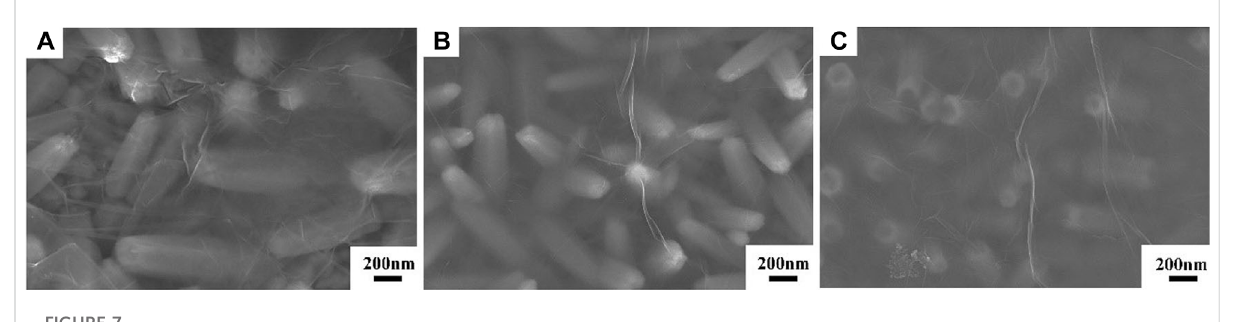
FIGURE 7 SEM micrographs ZnO-2rGO (A) , ZnO-5rGO (B) , and ZnO-8rGO (C) .